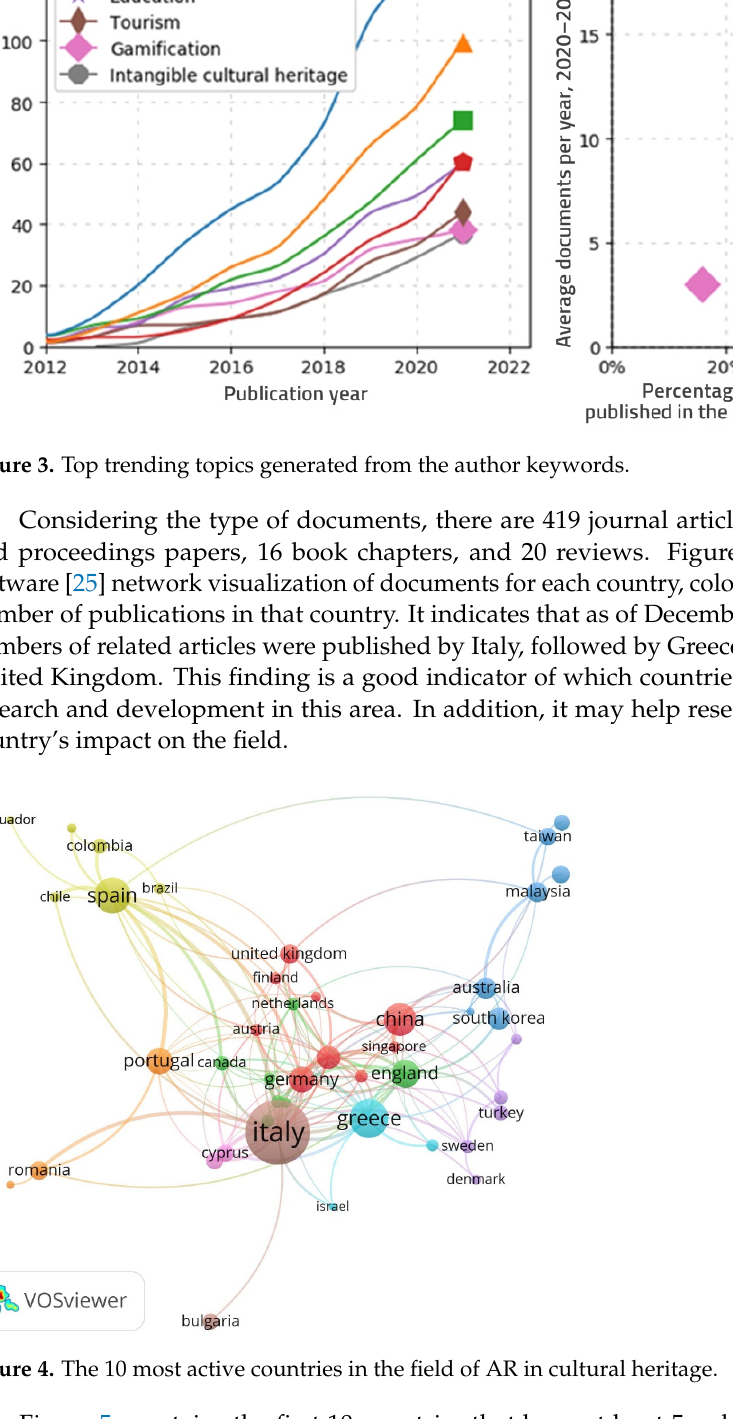
( b ) Figure 5. The 10 most active countries by number of documents ( a ) and citations ( b ). 3. Top Trending Applications of AR in Cultural Heritage Over the last decade, AR technologies had significant growth. There has been steady progress in the development of AR applications for CH, which has led to the development of engaging apps that are making a greater impact on several topics.